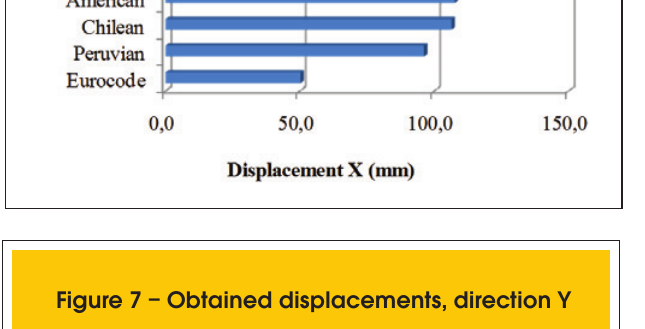
Figure 8 – Obtained total forces, direction X